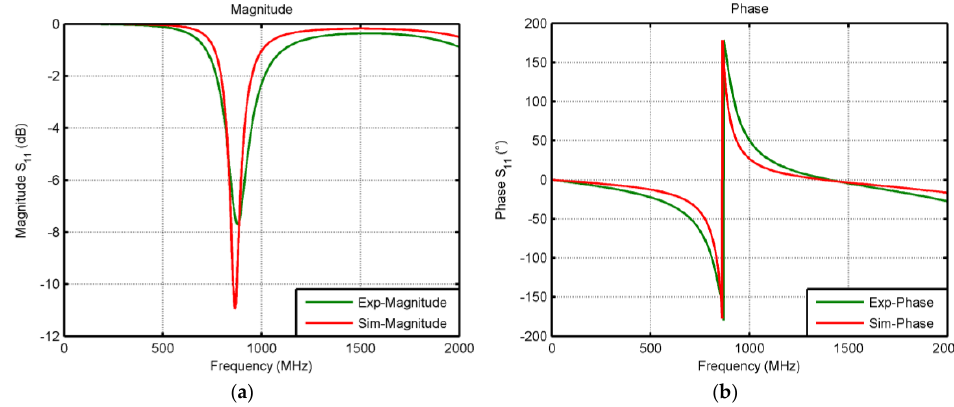
Figure 5. Experimentally measured (green solid line) and simulated (red solid line) magnitude ( a ); and phase ( b ) of differential S-parameter of the dipole antenna.